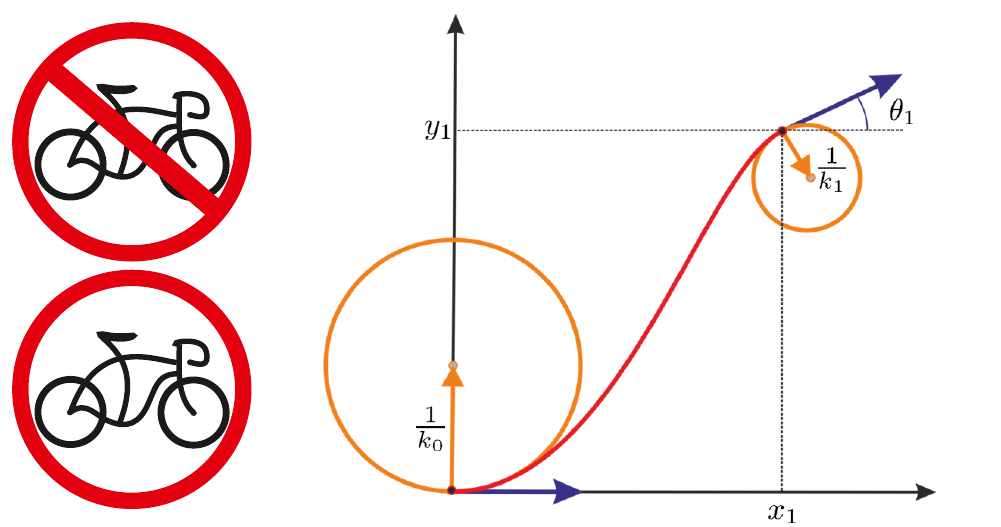
Figure 1. In the four-dimensional model of the visual cortex, an occluded contour is completed via the planar projection of a sub-Riemannian length-minimizer in the space R 2 × SO ( 2 ) × R = M (cid:51) ( x , y , θ , k ) of positions, orientations, and curvatures. In the left column, we show an example of the image with partially occluded contours and the complete image. In the right column, we show a trajectory that satisfies the given boundary conditions. The curvature is visualized as its reciprocal—the radius of the osculating